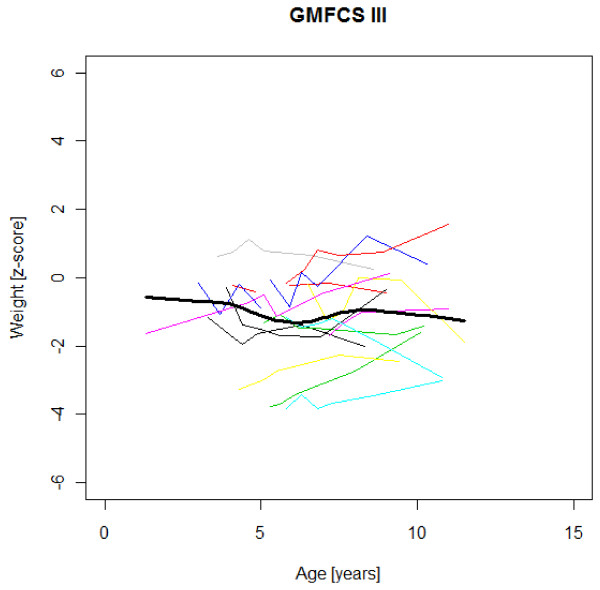
Weight z-scores in GMFCS III. Weight z-score at different age in 15 children with CP spastic diplegia, GMFCS III. Their mean z-score development with age is shown in black.